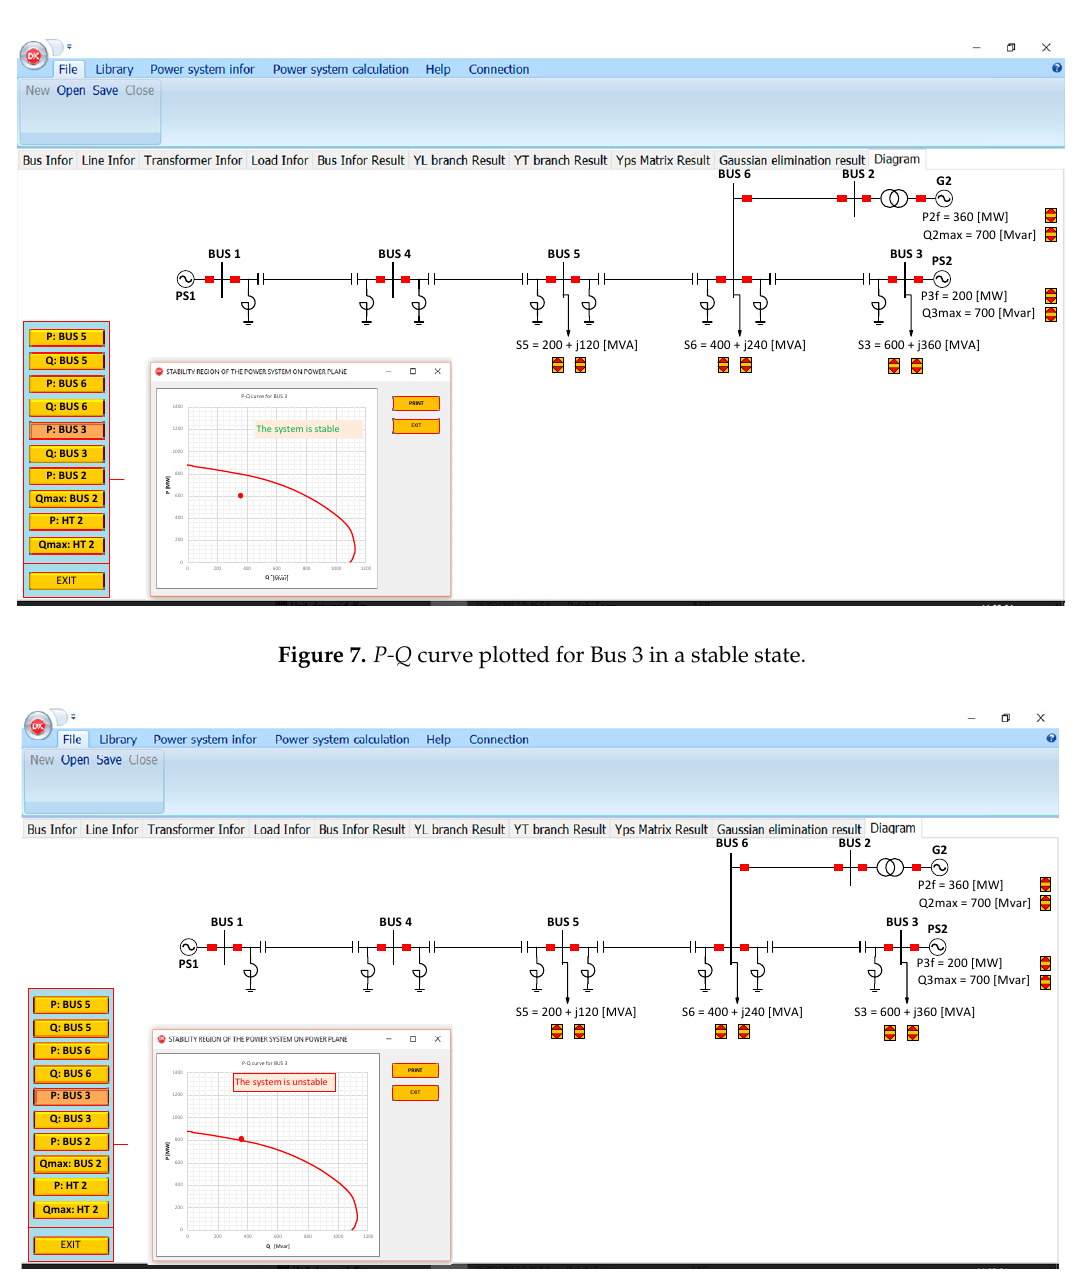
Figure 8. P - Q curve plotted for Bus 3 in an unstable state.